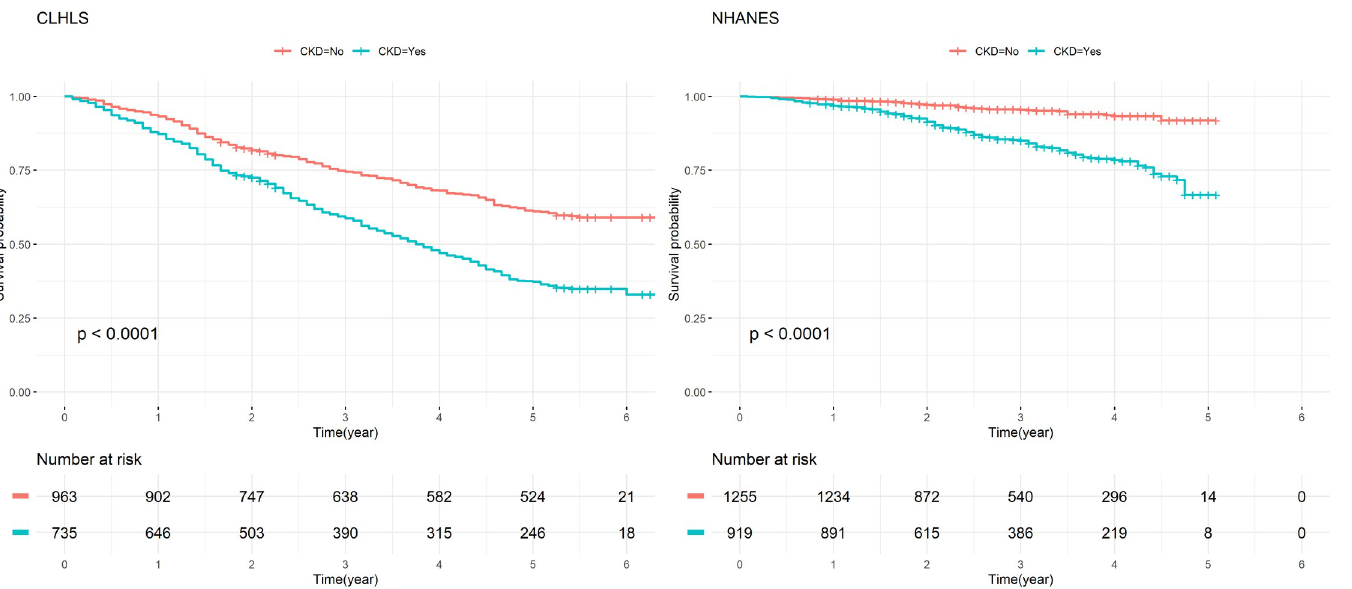
Fig 1. Kaplan-Meier Curve of CKD. CLHLS: 2012–2018. NHANES: